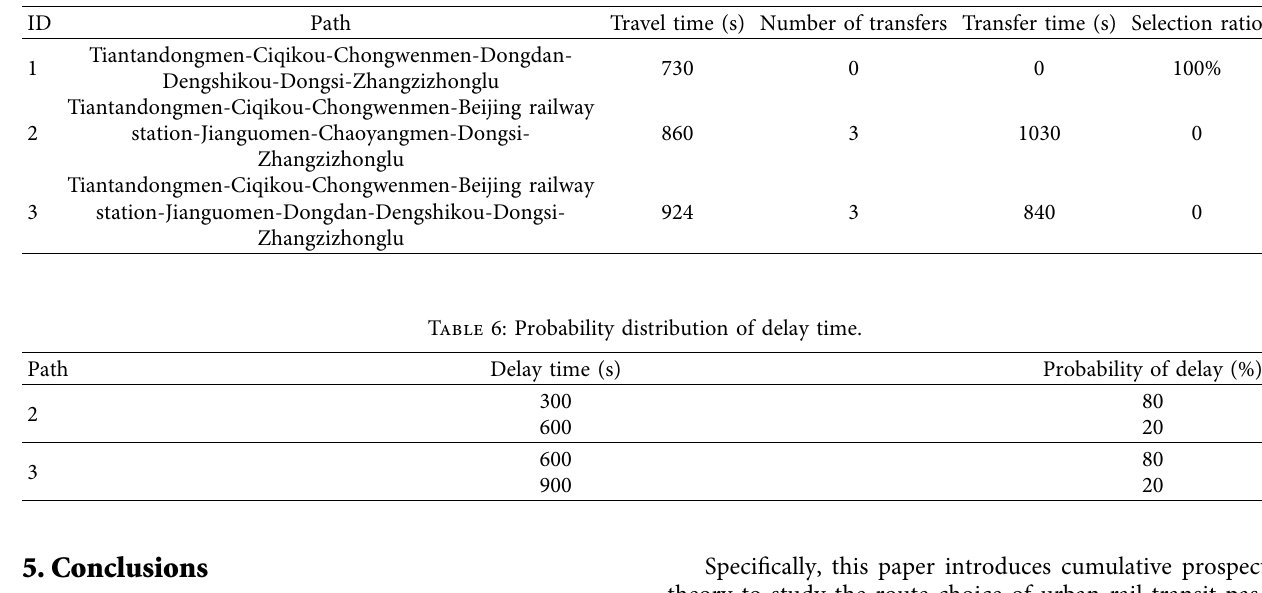
Table 5: Path attribute table when no emergencies occur.